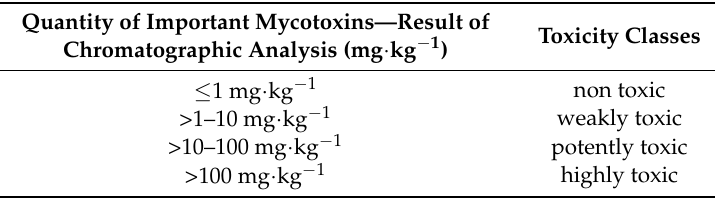
Table 2. Toxicity classes of mould biomasses